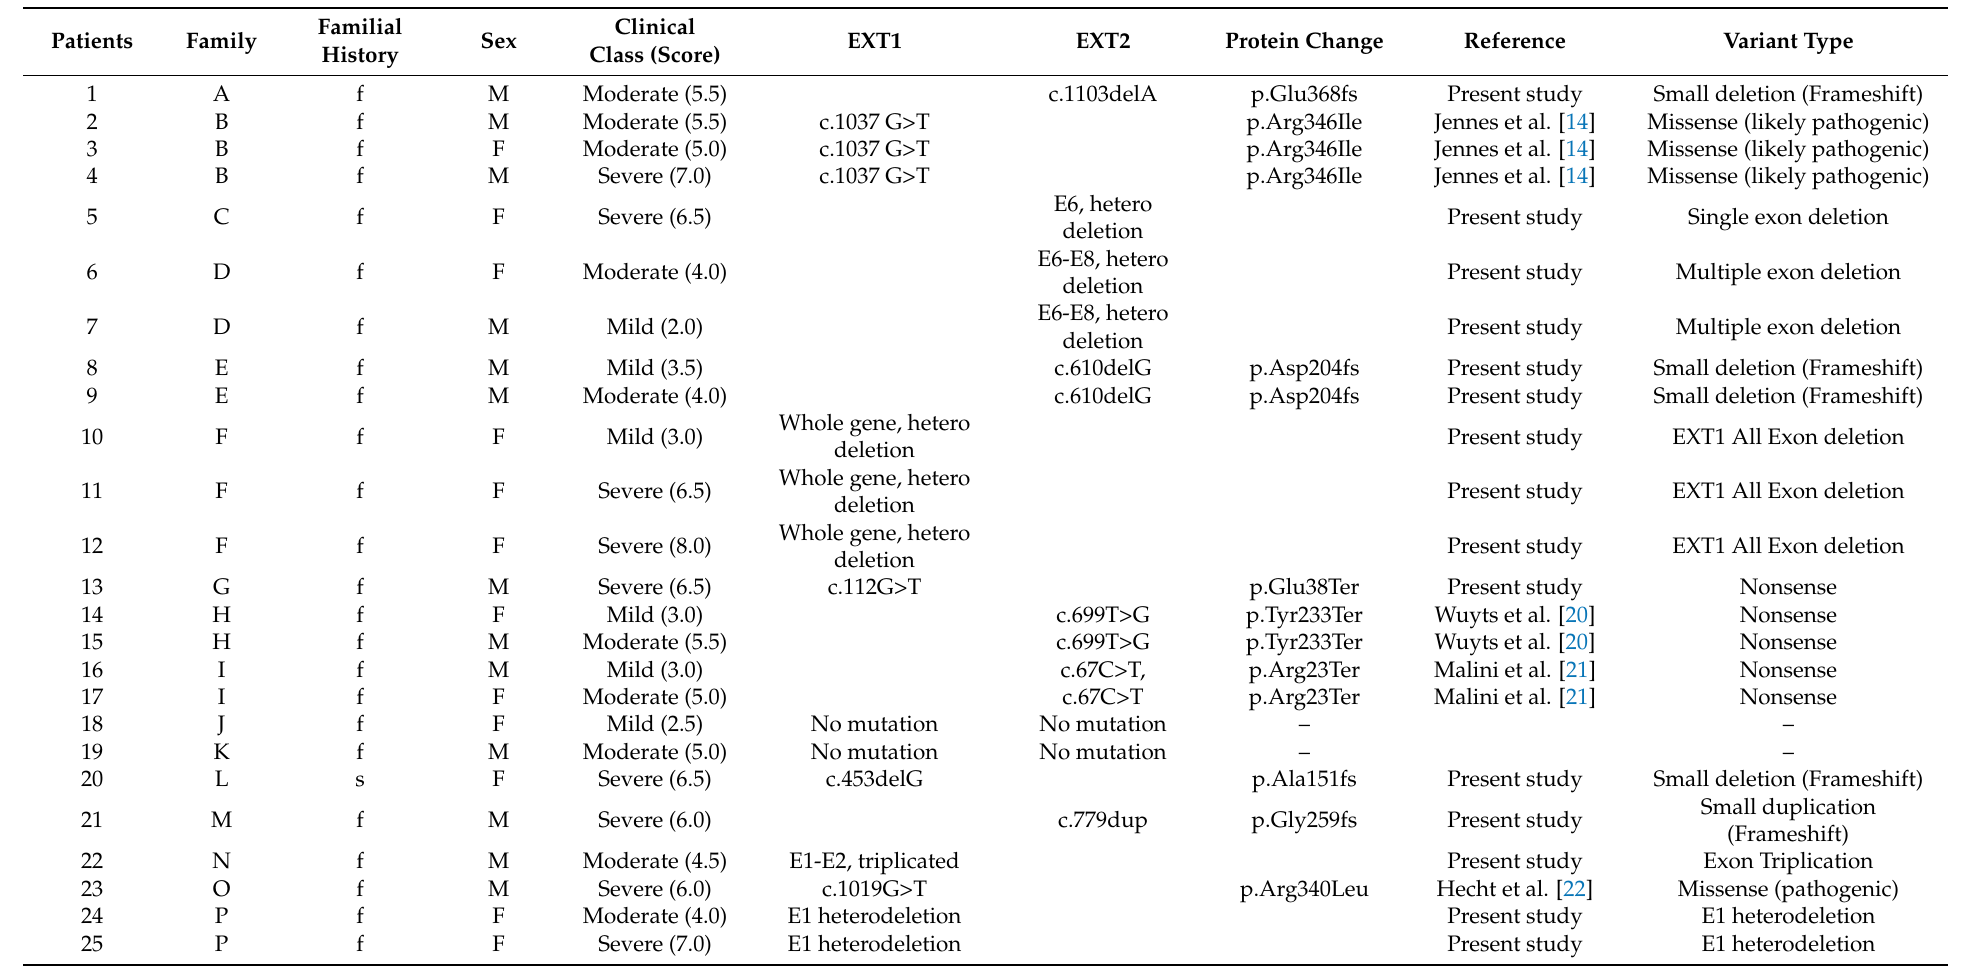
Table 3. Gene mutations in